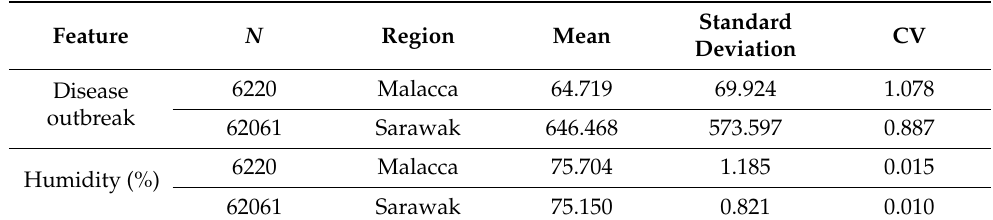
Table 6. Descriptive statistics about the humidity and the scale of mouth, foot and hand disease outbreak in Sarawak and Malacca.